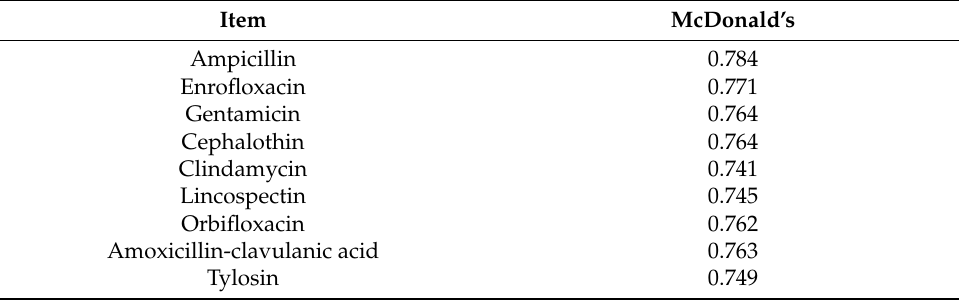
Table 5. Results of McDonald’s omega reliability